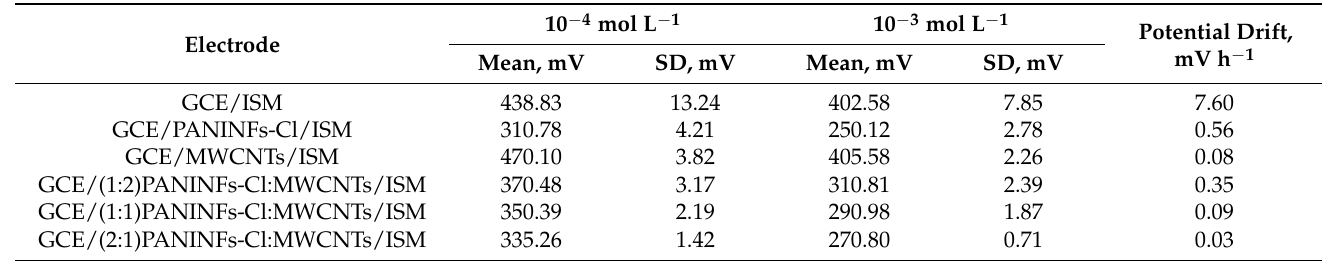
Table 5. Reversibility and short-term stability of the electrode potential determined in NaCl solutions with a concentration of 10 − 4 and 10 − 3 mol L − 1 . Mean values and standard deviation obtained for 5